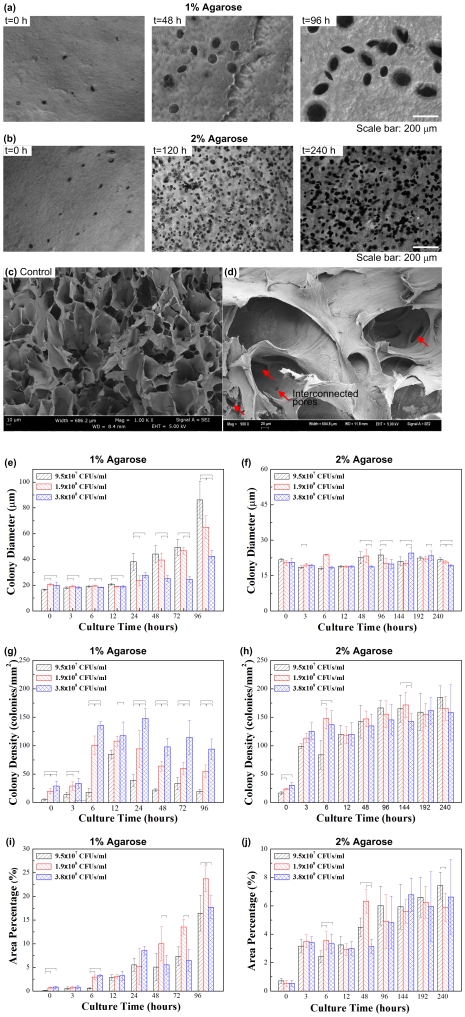
Characterization of living porogen growth in hydrogels and subsequent pore formation.Crystal violet staining of bacterial colonies in 1% (a) and 2% (b) hydrogels. SEM images of pores created using living porogens (c) as compared to controls (d). The colony size (e–f), density (g–h), and the pore area percentage (i–j) are presented over the culture time for 1% and 2% hydrogels at initial bacterial seeding concentrations of 9.5×107, 1.9×108 and 3.8×108 CFUs/ml.